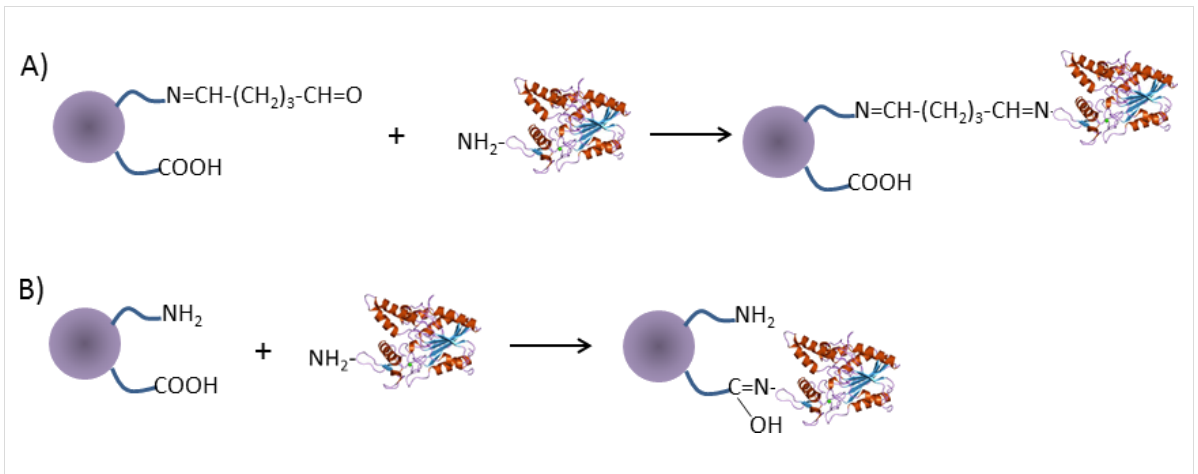
Figure 8: Schematic presentation of two types of biocomposite preparation: A) nanoparticles with glutaraldehyde and enzyme; B) nanoparticles after surface modification and enzyme attachment.